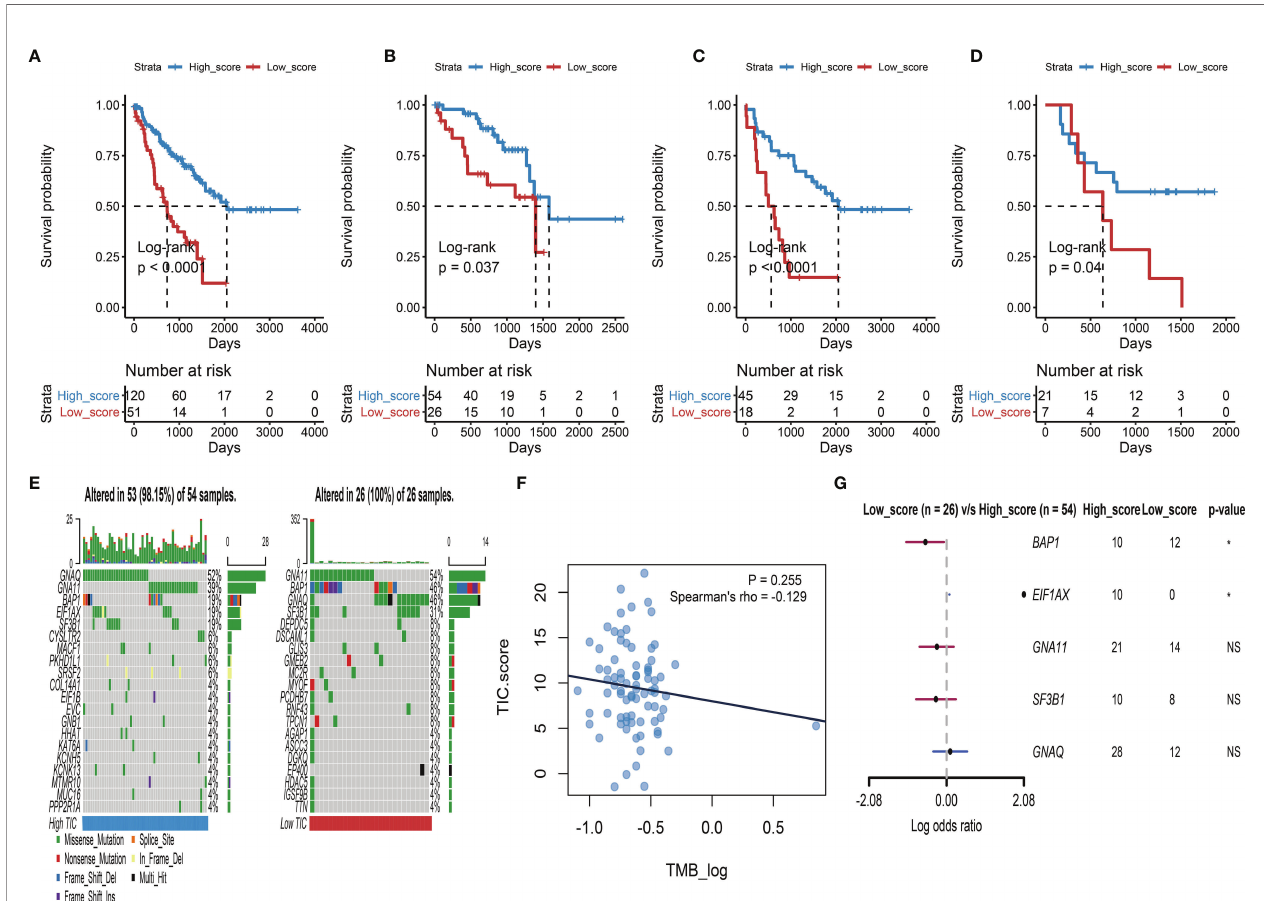
FIGURE 4 | Survival analysis and somatic mutation. (A) Kaplan – Meier (KM) plot of high-TIC score and low-TIC score groups in all UM patients. (B) KM plot of high- TIC score and low-TIC score patients in the TCGA-UVM cohort. (C) KM plot of high-TIC score and low-TIC score patients in the GSE22138 cohort. (D) KM plot of high-TIC score and low-TIC score patients in the GSE84976 cohort. (E) The top 20 mutant genes in the high-TIC score and low-TIC score groups. (F) The correlation analysis between tumor burden mutation (TMB) and TIC scores. (G) Different somatic mutations between high-TIC score and low-TIC score